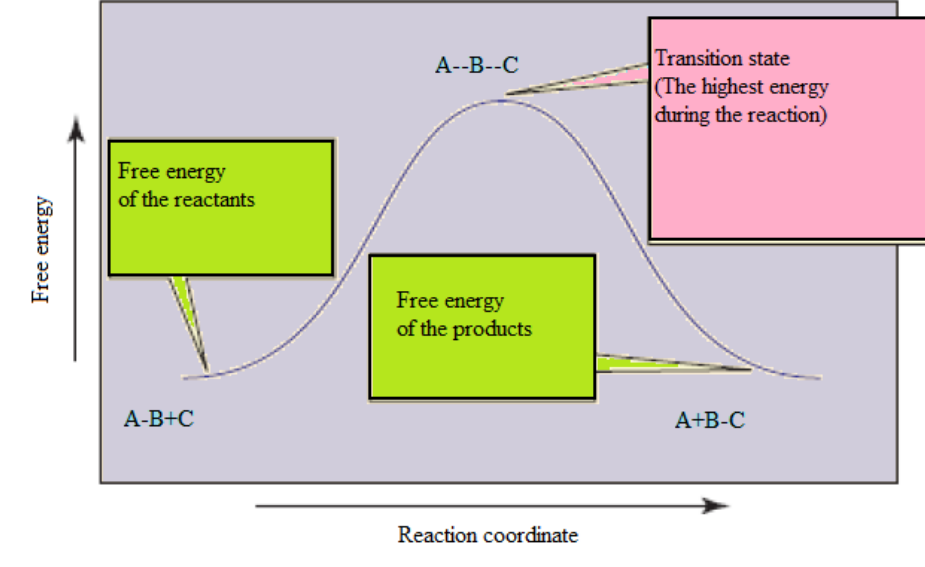
Figure 5. Energy transition [7].